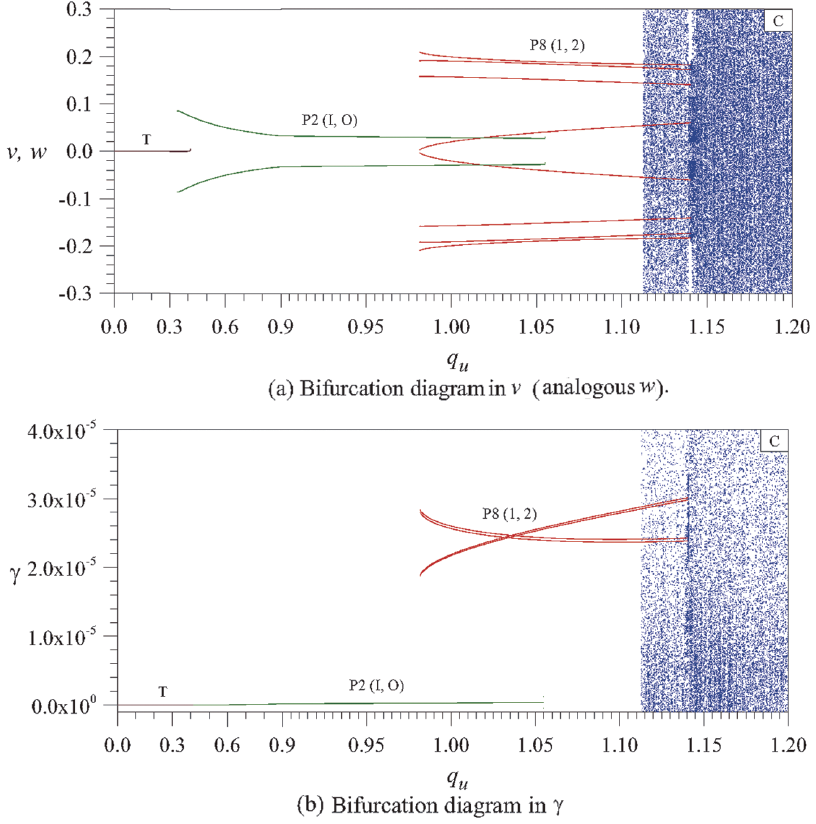
Fig. 4. Bifurcation diagram of the Poincaré map for the beam subject to an axial load at Ω u = 2 ω 0